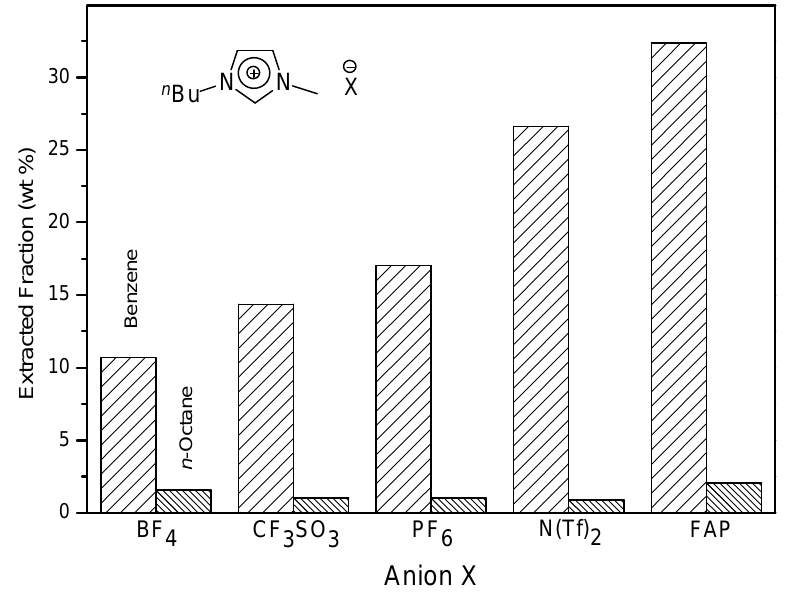
Figure 1. Extracted fraction of benzene and n -octane from a 10 wt % benzene solution in n -octane (LI:benzene ratio of 1:1, mol/mol) by 1- n -butyl-3-methylimidazolium based